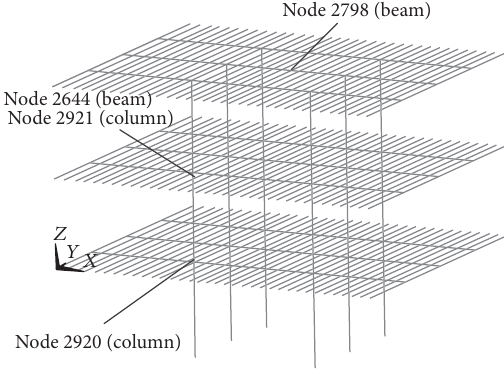
Figure 14: Arbitrarily selected points of the